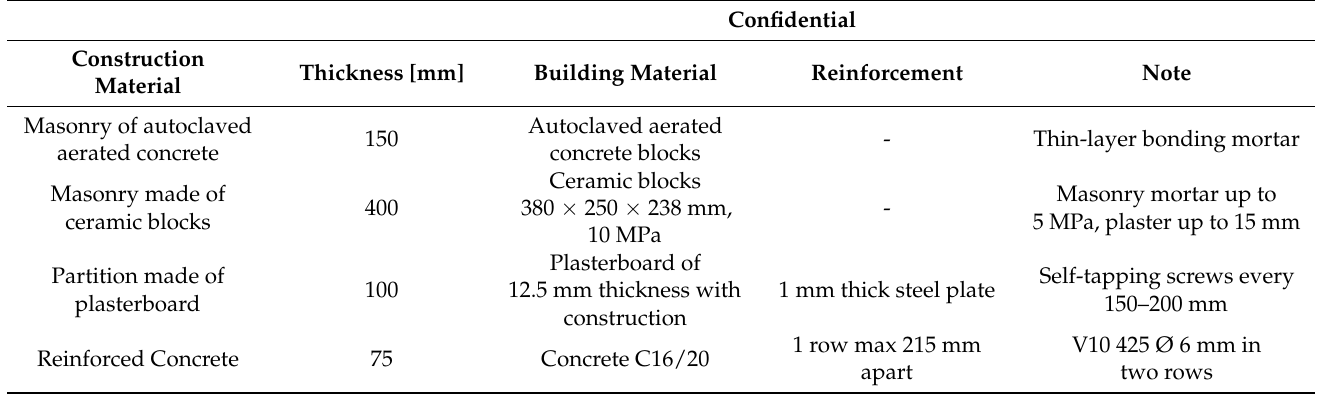
Table 1. Specification of walls, partitions and ceilings for confidential level